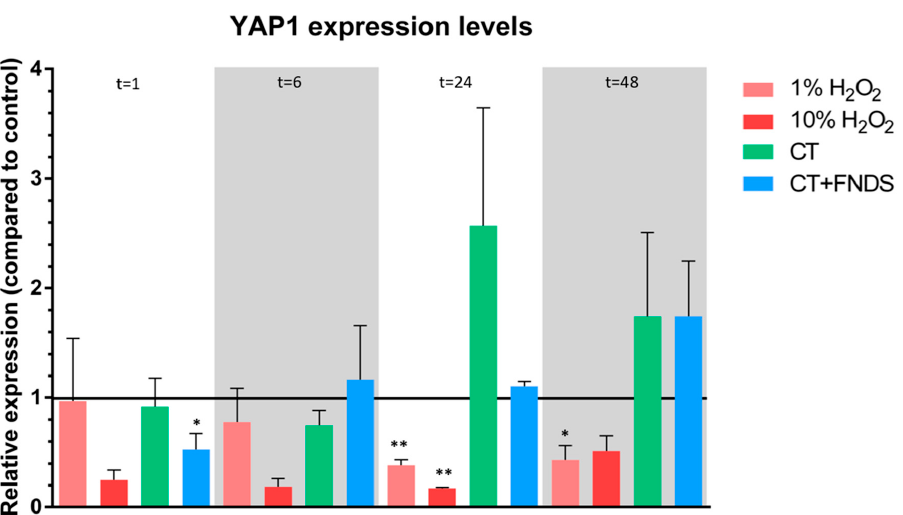
Figure 5. Relative expression of YAP1, the primary transcription factor involved in antioxidant response. The colors represent different conditions, measured at 1/6/24/48 hours, respectively. Values are averages out of 3–4 independent qPCR runs that were performed in duplicates. Error bars show the standard error of the mean. Significance was tested against the control (* p ≤ 0.05, ** p ≤ 0.01).